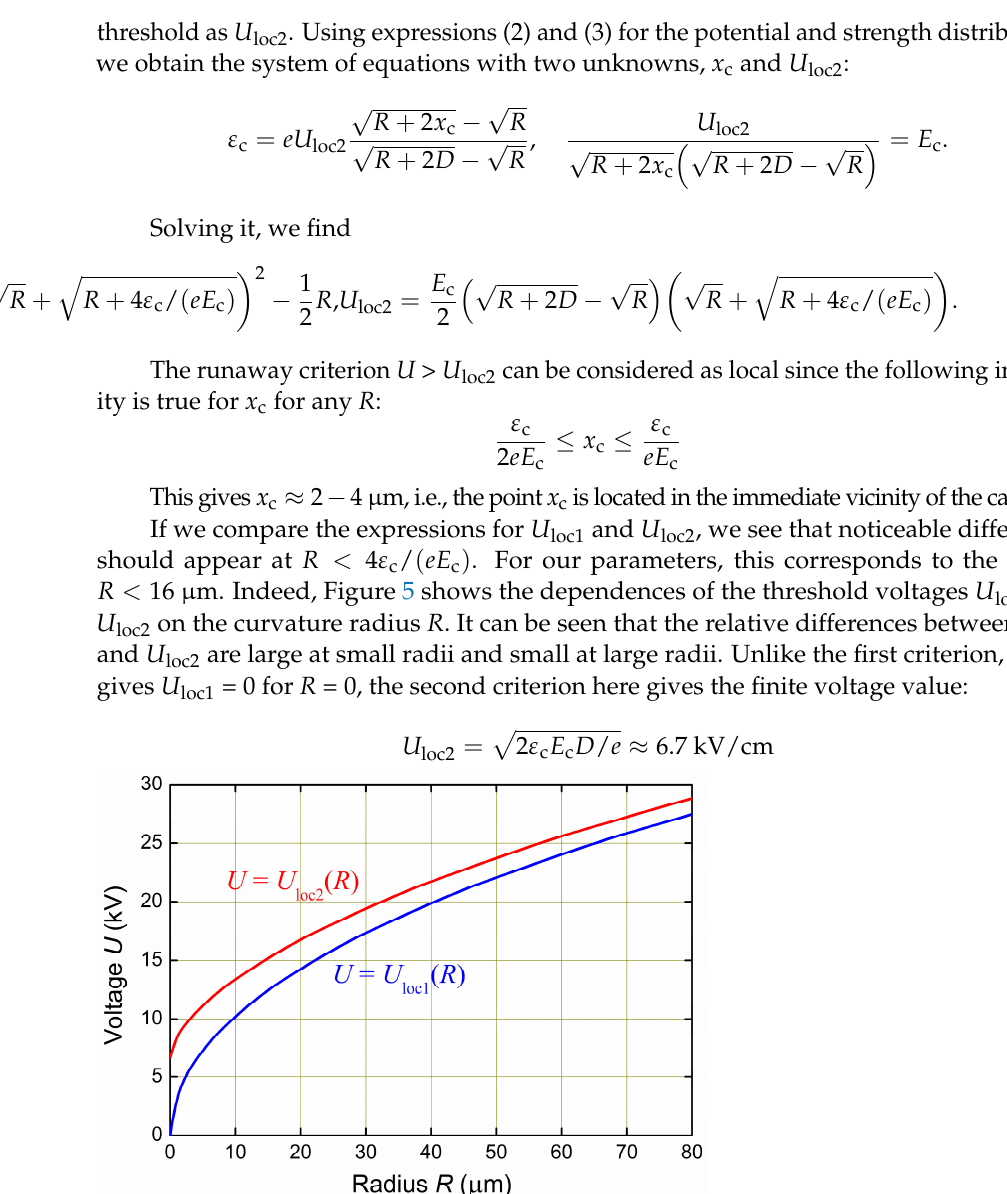
Figure 5. The dependences of the runaway threshold voltages U loc1 and U loc2 on the radius R . They correspond to local criteria of different accuracy (8) and (9): blue and red lines, respectively. ε= ≈ 2 / 6.7 kV/cm U E D e loc2 c c